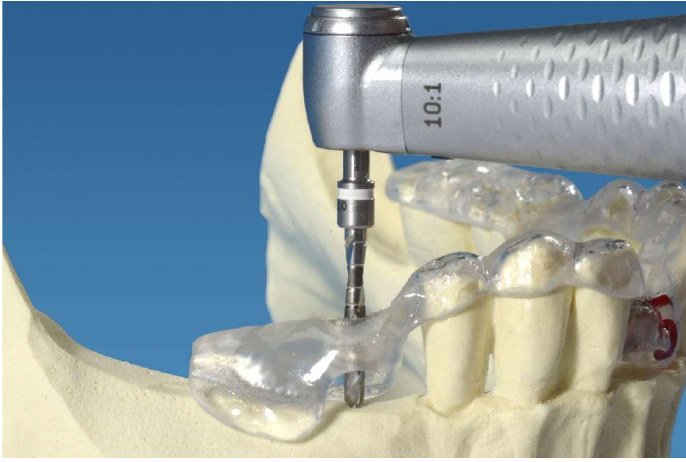
Figure 1. Orientation template fixed on the mandibular model. The pilot cavity in the region of tooth 45 was performed with a 2.0 mm pilot